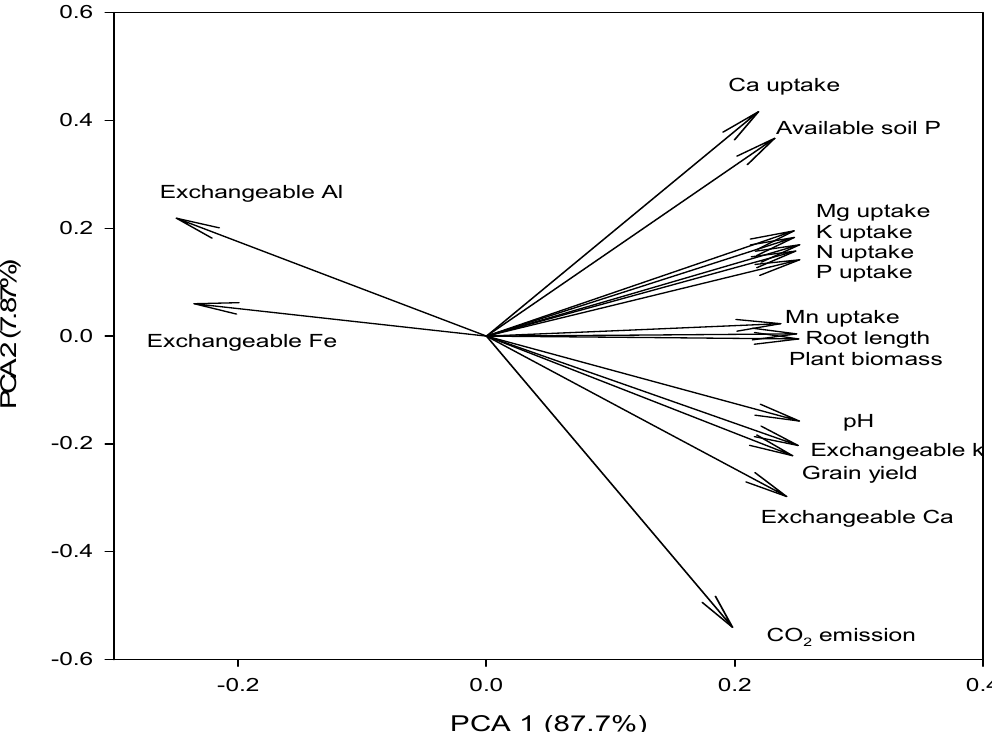
Figure 5. Principal component analysis (PCA) of different variables.